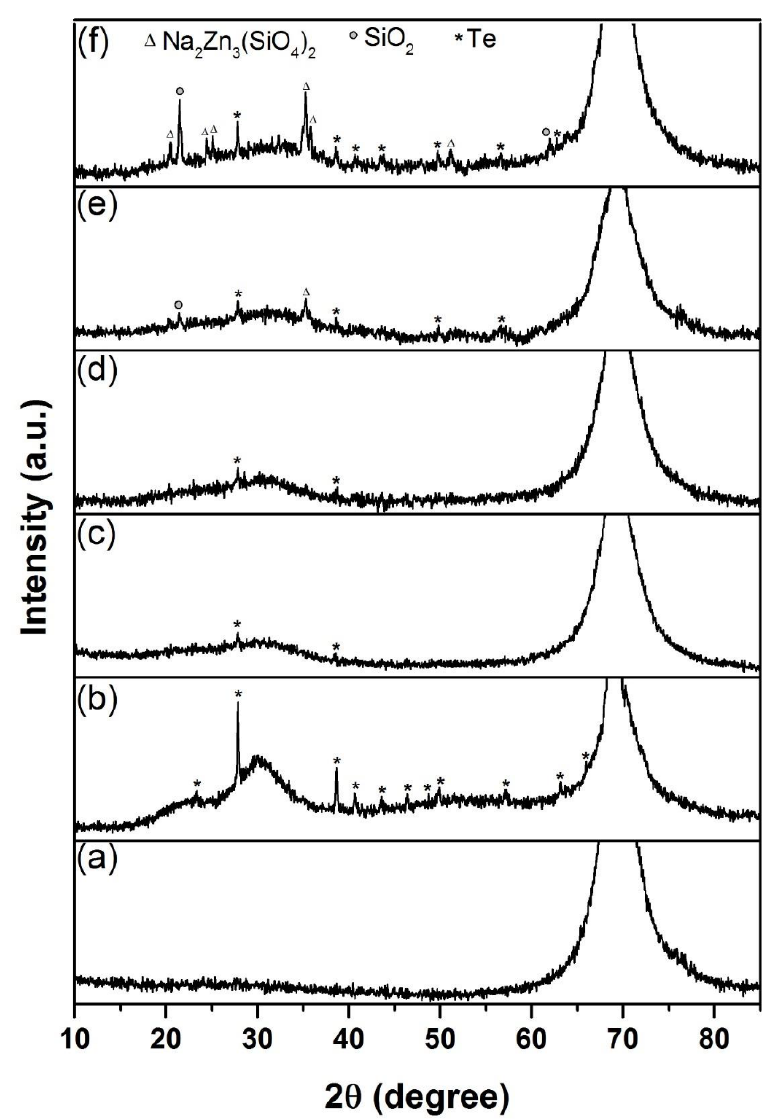
Figure 14. XRD patterns of ( a ) Si 3 N 4 -on-silicon substrate and samples ( b ) K470, ( c ) K520, ( d ) K570, ( e ) K600 and ( f ) K650.